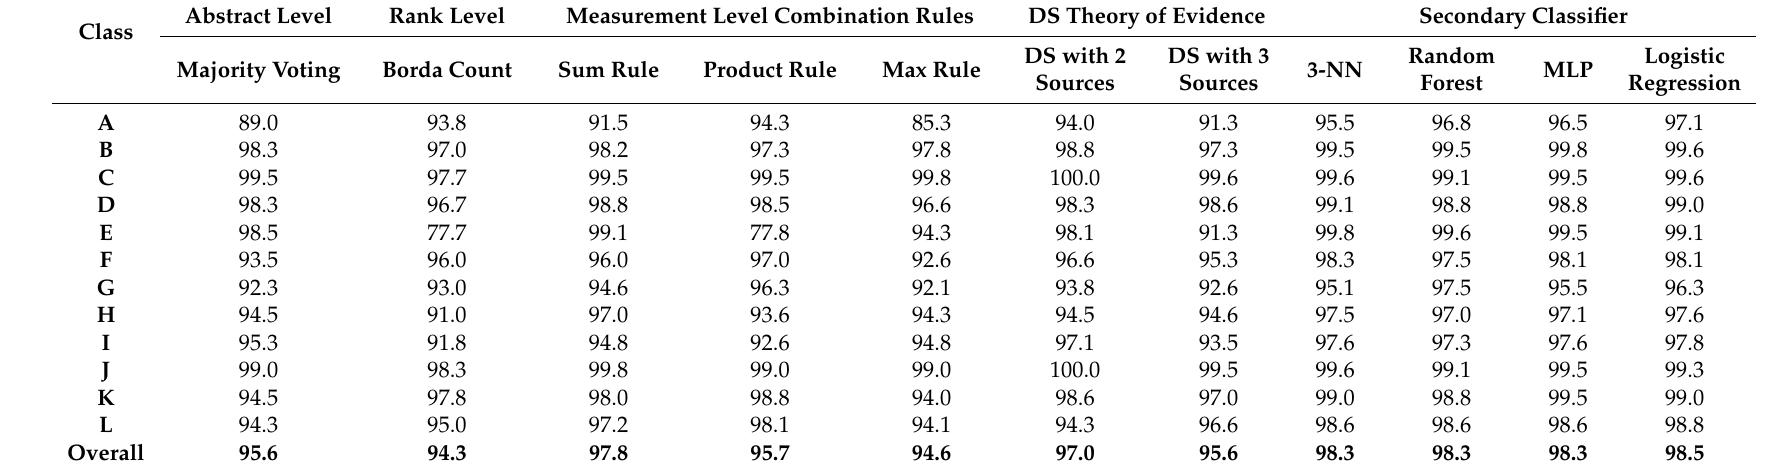
Table 18. Class-wise percentage accuracy for the classifier combination methods.